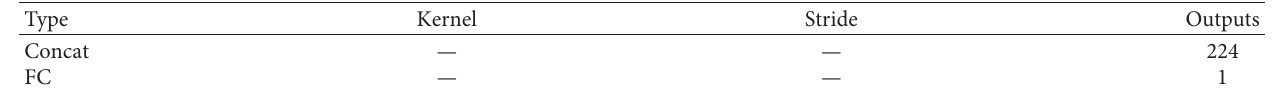
Table 6: Concatenation layer of